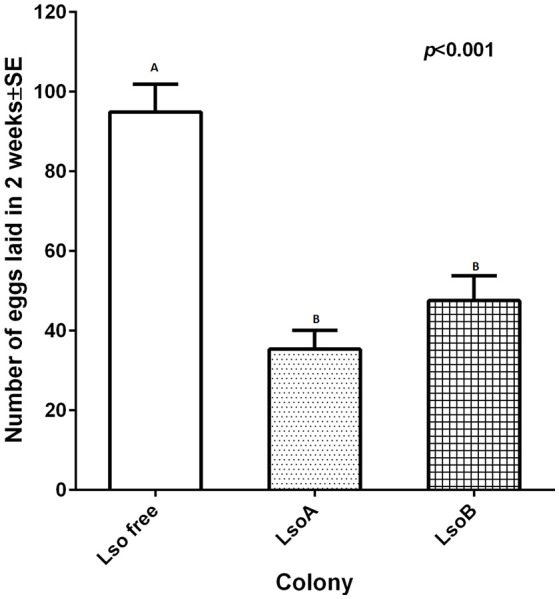
Two-week oviposition by individual females from each colony. One couple of insects was allowed to mate and to lay eggs for 2 weeks. Each column represents the mean and standard error of the number of eggs laid by individual females. Different letters indicate statistical differences between insect classes at p < 0.05 using LSD t-test.